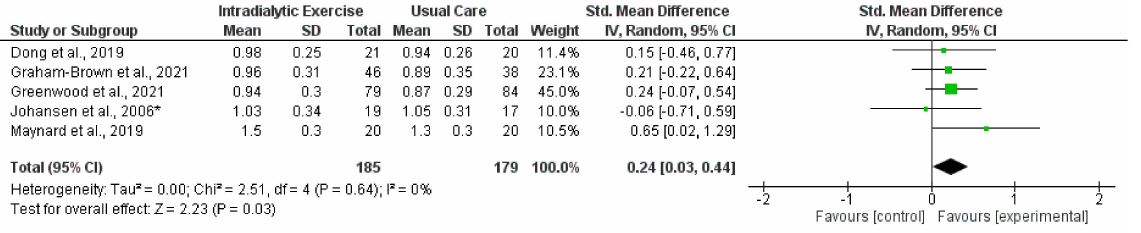
Figure 9. Effect of intradialytic exercise on gait speed (m/s) in individuals receiving haemodialysis. Data are expressed as standardised mean difference and 95% CI. * Data for exercise and control groups only